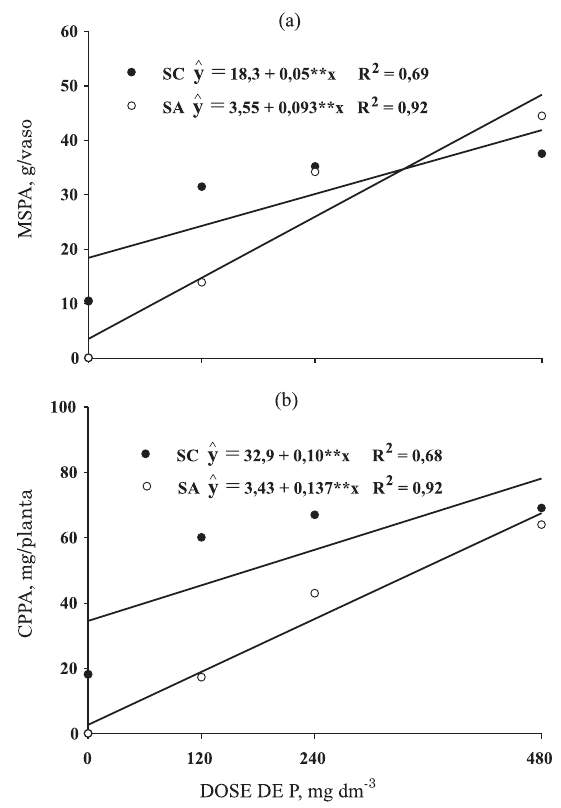
Figura 3. Matéria seca da parte aérea (a) e conteúdo de P na parte aérea (b) de dois cultivos sucessivos de braquiária em função das doses de fósforo num Latossolo Vermelho, na área de solo cultivada (SC) e solo adjacente